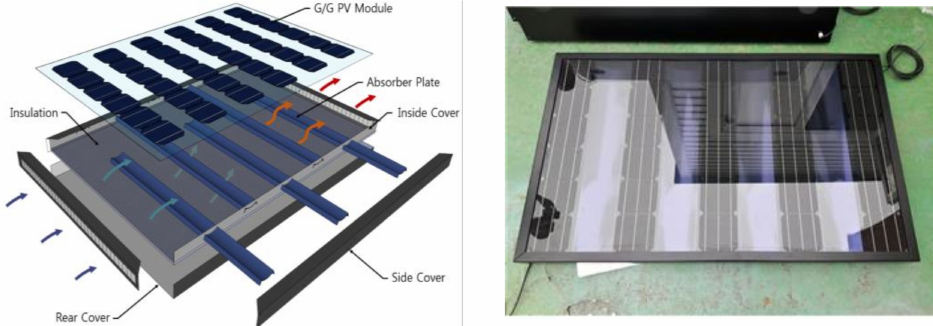
Figure 1. New design of air-type PVT collector for efficient thermal performance. From [21].